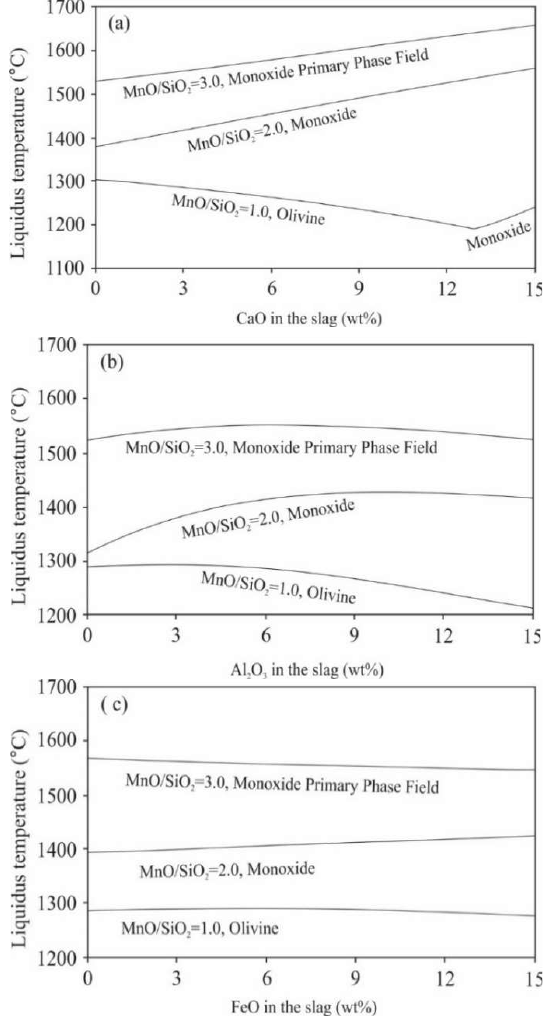
Figure 2. Effects of CaO, Al 2 O 3 , and “FeO” on liquidus temperatures at different MnO/SiO 2 ratios in equilibrium with iron calculated with FactSage 7.2, ( a ) CaO in the slag,( b ) Al 2 O 3 in the slag,( c ) FeO in the slag.